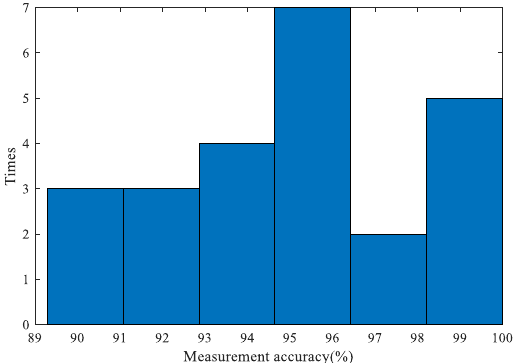
Figure 17. The histogram of individual larch measurement accuracies.